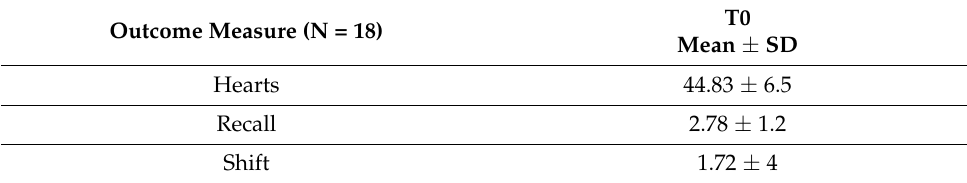
Table 3. Oxford Cognitive Scale (OCS) evaluated before (T0) rehabilitation.